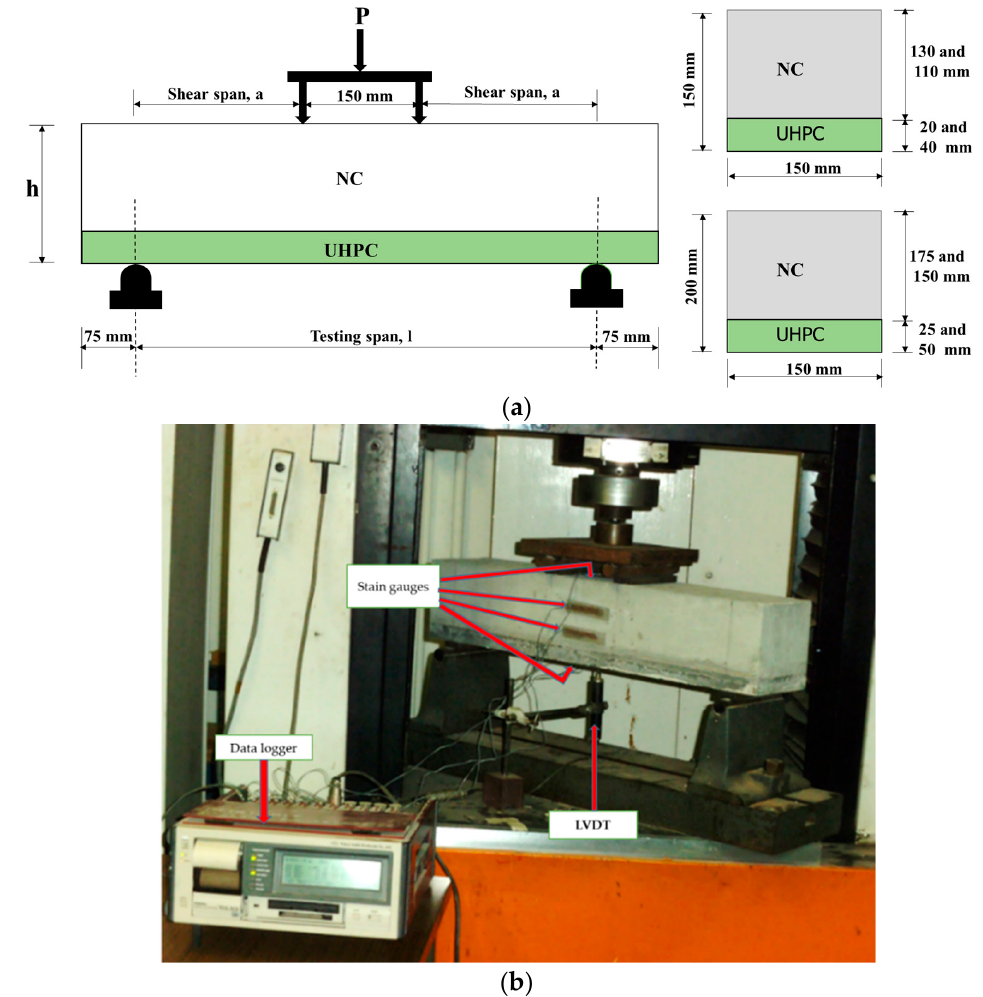
Figure 3. ( a ) Schematic for the load test of hybrid NC-UHPC beams; ( b ) hybrid test beams loaded under testing machine.